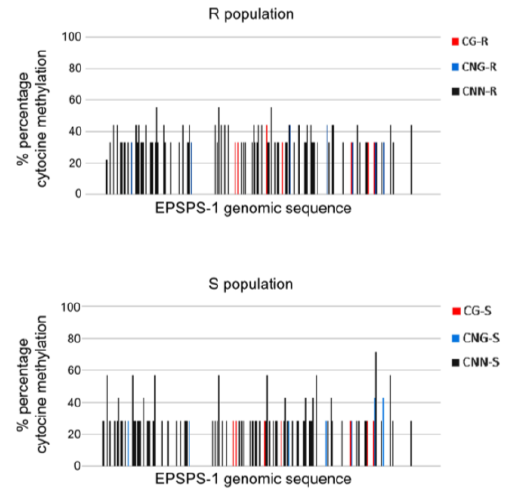
Figure 2. Bisulfite sequencing data shown as percentage methylation in CG, CNG, and CNN islands of the genomic DNA fragment of the EPSP - synthase 1 gene of Conyza canadensis . Vertical lines indicate the positions of cytosines. The height of each line represents the percentage of 5′-Me-C at that position. The horizontal line of the x -axis on each graph represents the DNA sequence of the EPSP-synthase 1 gene. S population: susceptible population; R population: resistant population.